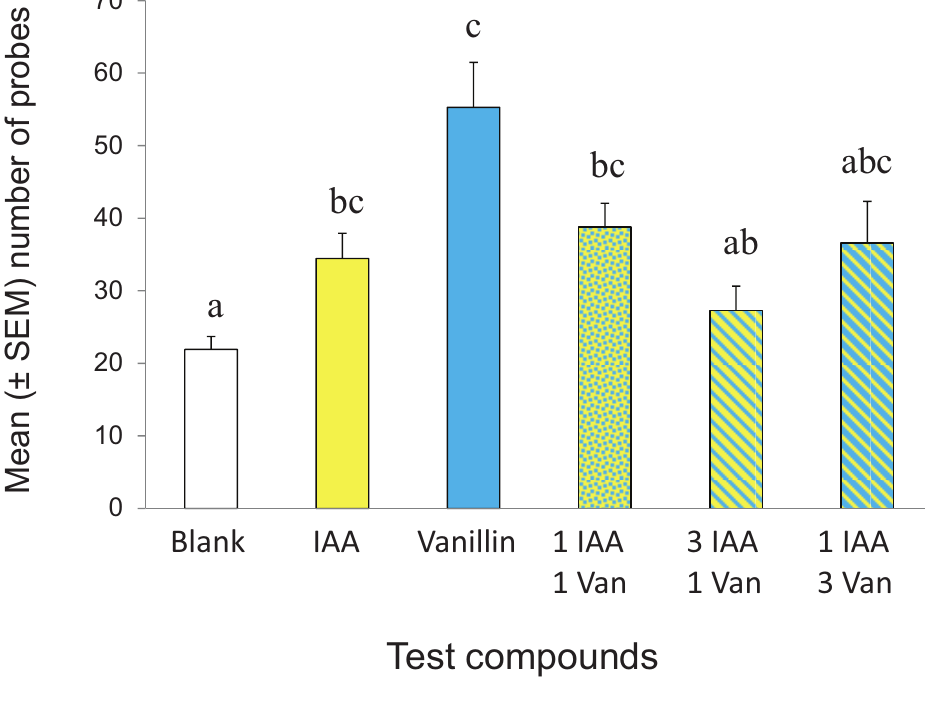
Figure 5. Response of vanillin-conditioned psyllids to vanillin (Van) isoamyl acetate (IAA), and binary mixtures of each in different proportions. N = 30 replicates for each